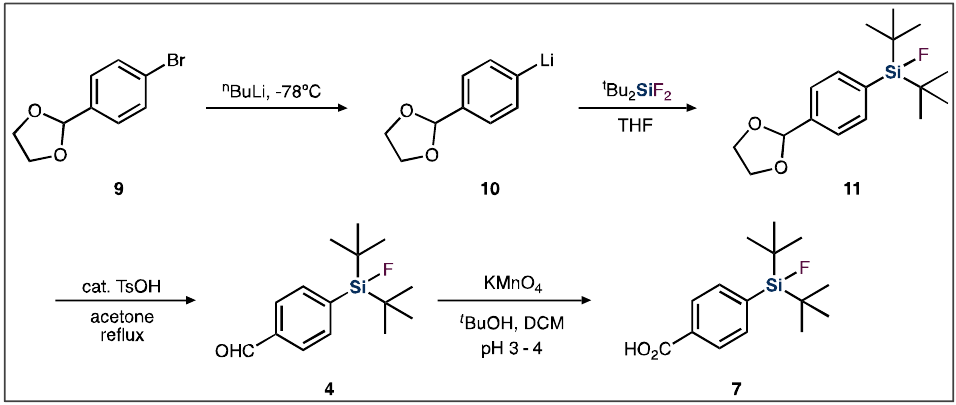
Figure 4. General SiFA building block synthetic scheme used for SiFA-peptide syntheses.